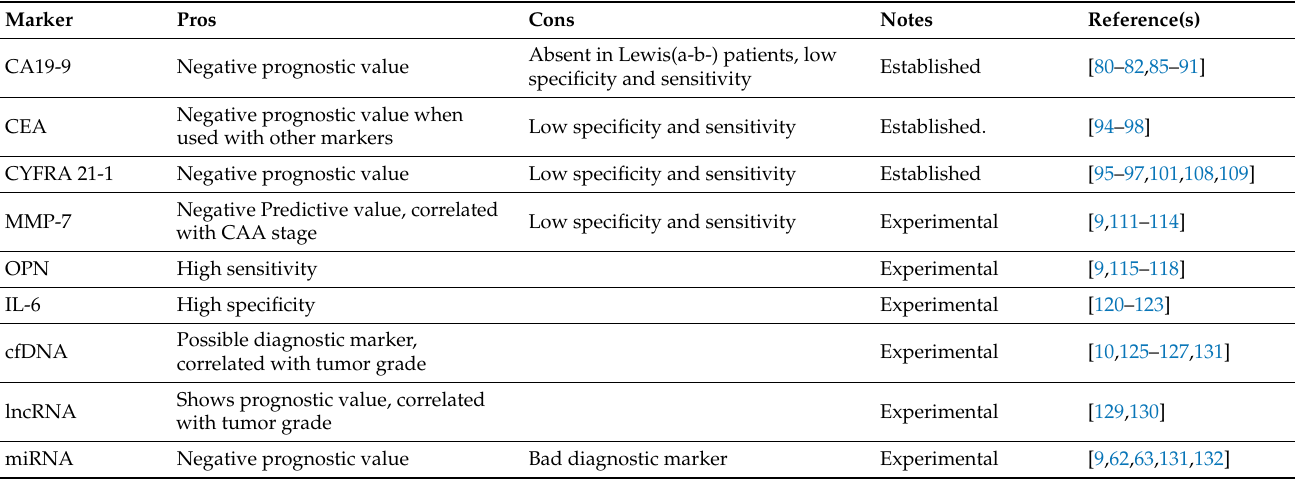
Table 2. Some of the current and additional markers for early detection of